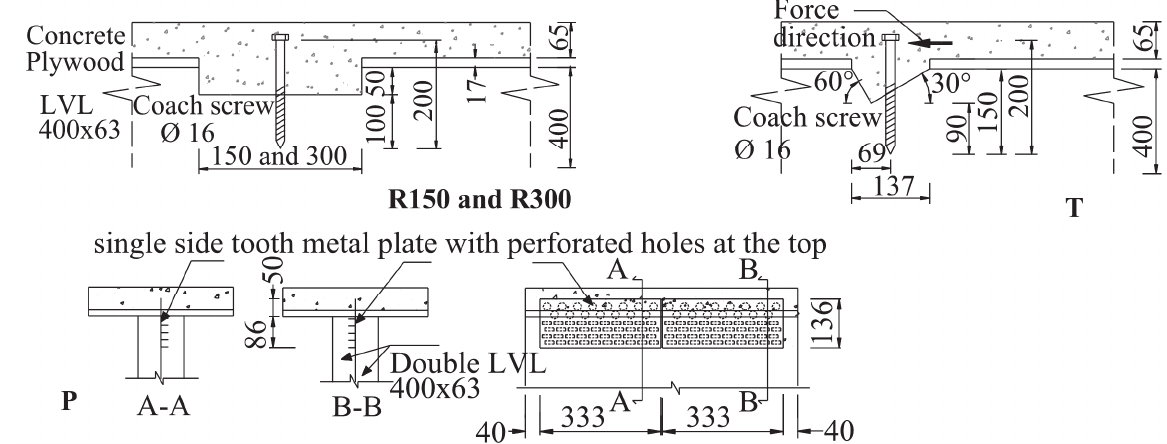
Figure 3: different connections: R150, T, R300 and P adopted in the experimental program by Yeoh